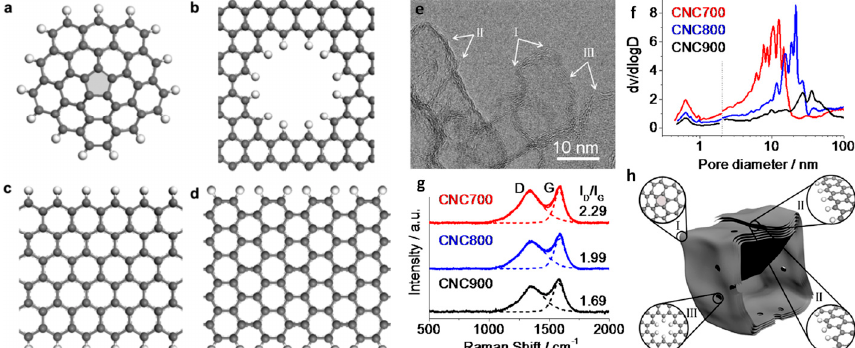
Figure 4. Defect models of ( a ) Pentagon (highlight), ( b ) Hole, ( c ) Zigzag edge and ( d ) Armchair-like edge. C atom (gray), H atom (white). ( e ) Representative HR-TEM image of CNC700. ( f ) Pore size distributions for different samples. ( g ) The corresponding Raman spectra of CNC. ( h ) Schematic illustration of a carbon nanocage structure with three typical defective locations I (the corner), II (the broken fringe) and III (the hole). Reprinted with permission from Ref. [27], 2015 American Chemical Society.